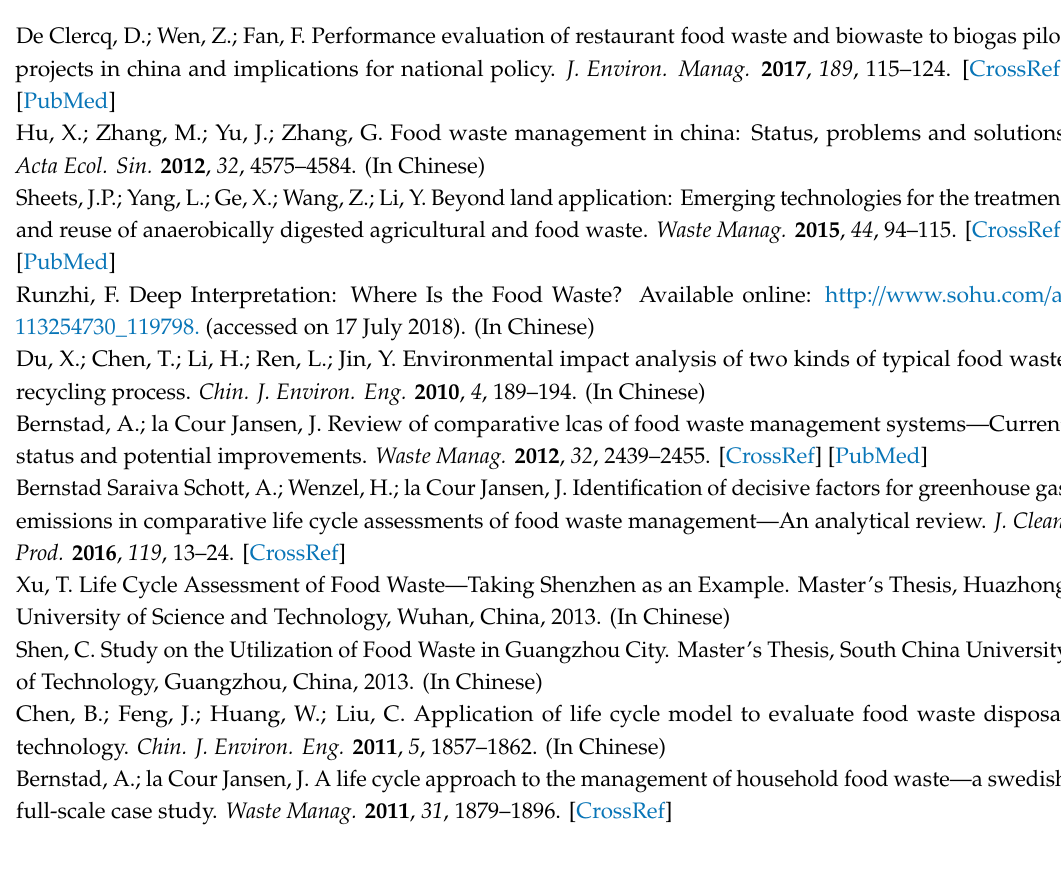
Table S1: Life-cycle inventory of restaurant food waste in